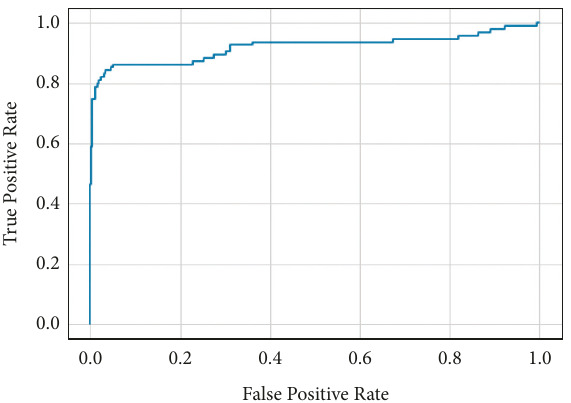
Figure 7: ROC curve orange.